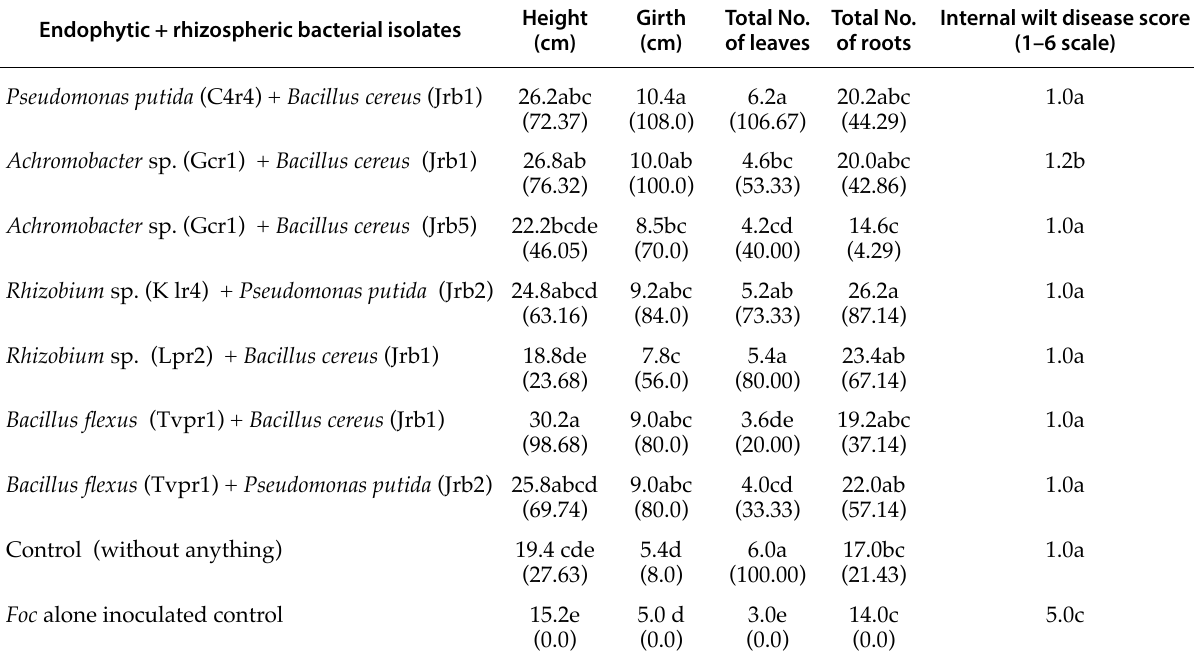
Table 3. Mean host plant parameters and Fusarium wilt severity scores from combined applications of endophytic and rhizospheric bacterial isolates in banana cv. Grand Naine (VCG-0124), assessed in pot experiments.* Endophytic + rhizospheric bacterial